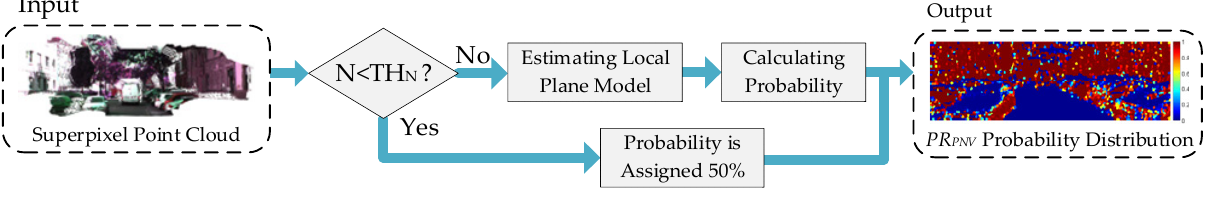
Figure 3. Flow chart of OD-PNV method.